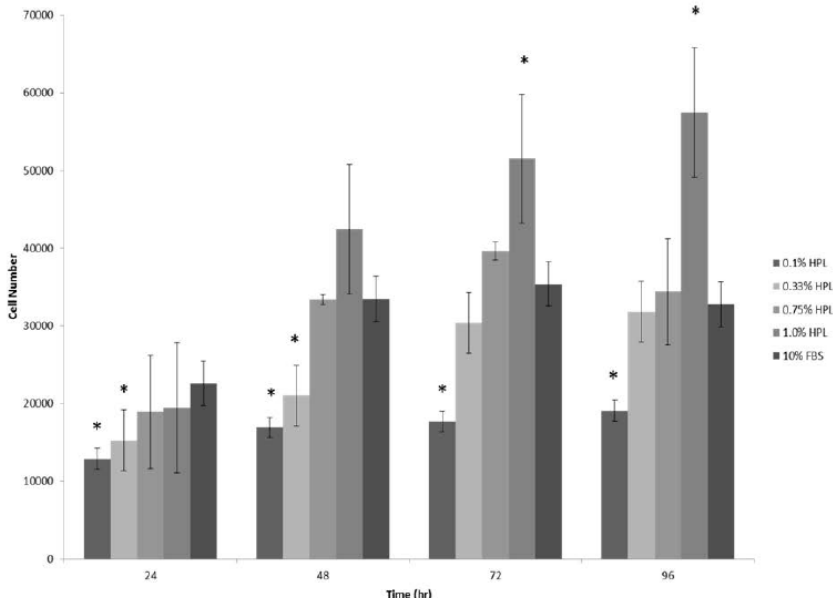
Figure 1. Effect of the concentration of HPL (Human Platelet Lysate) supplementation on ASC proliferation compared to 10% FBS. Stromal media containing 0.1%, 0.33%, 0.75%, 1.0% PL, and 10% FBS were tested for impact on ASC proliferation. Data is reported as the mean ± standard error. * Significant difference; p < 0.05.